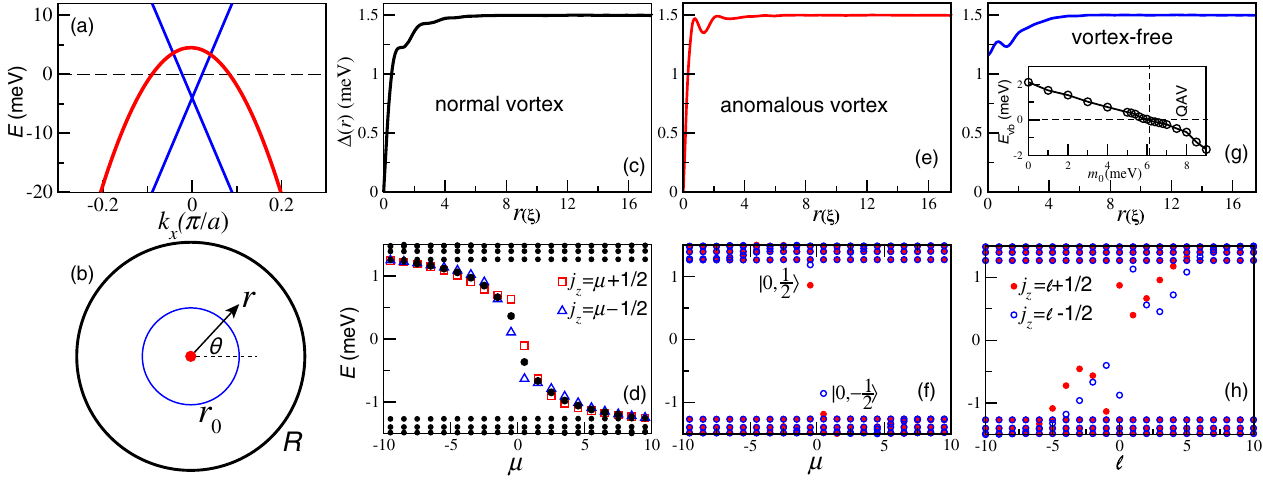
FIG. 2. (a) The effective holelike band for bulk states (red line) and the TSS band (blue line) observed in Ref. [28] near the Γ point. (b) The disc geometry with radius R . Short-ranged couplings have an exponential decay length r 0 from the centered magnetic ion. (c) – (h) The self-consistent pairing profile Δ ð r Þ , where r is measured in units of the coherence length ξ and the in-gap bound-states spectrum: (c,d) The normal magnetic-field-induced vortex. The SOC associated with the magnetic ion with λ 0 ¼ 6 . 6 meV splits the degenerate CdGM states j μ ; σ i (black circles) into two sets of spin-orbit-coupled bound states j j triangles). (e,f) The QAV induced by the magnetic ion for m 0 ¼ λ 0 ¼ 6 . 6 meV. All CdGM states j j higher binding energies above the SC gap. (g,h) The vortex-free state near the magnetic ion. The SOC splits the in-gap YSR states into two sets. Inset in (g): the QAV binding energy as a function of the exchange field m 0 . The QAV emerges beyond m c 0 ≃ 6 . 1